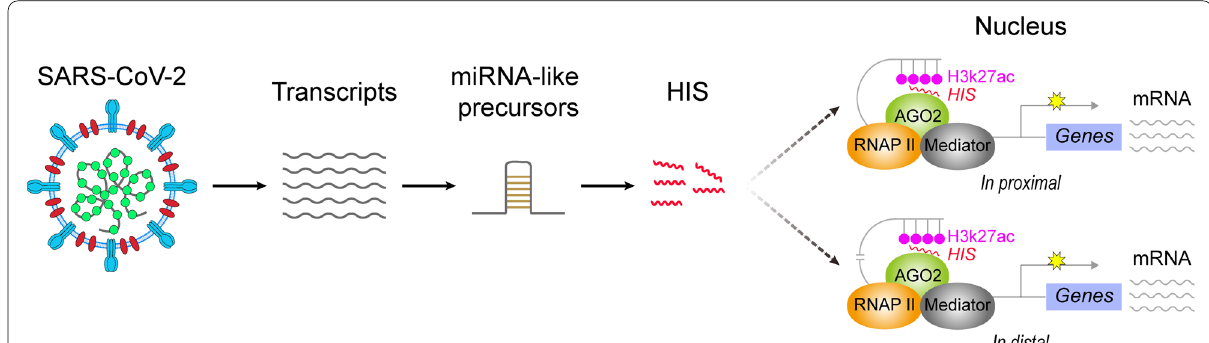
Fig. 2 HIS-SARS2 activates inflammation-related genes by targeting enhancer. After infection, SARS-CoV-2 can generate plenty of unknown transcripts, which may serve as the miRNA-like precursors and produce HIS. With the help of AGO2, HIS could bind to their targeting enhancers in the human genome. Subsequently, the interaction between enhancer and RNA polymerase II (RNAP II) mediated-mediators will promote the transcription of inflammation-related genes in proximal or in